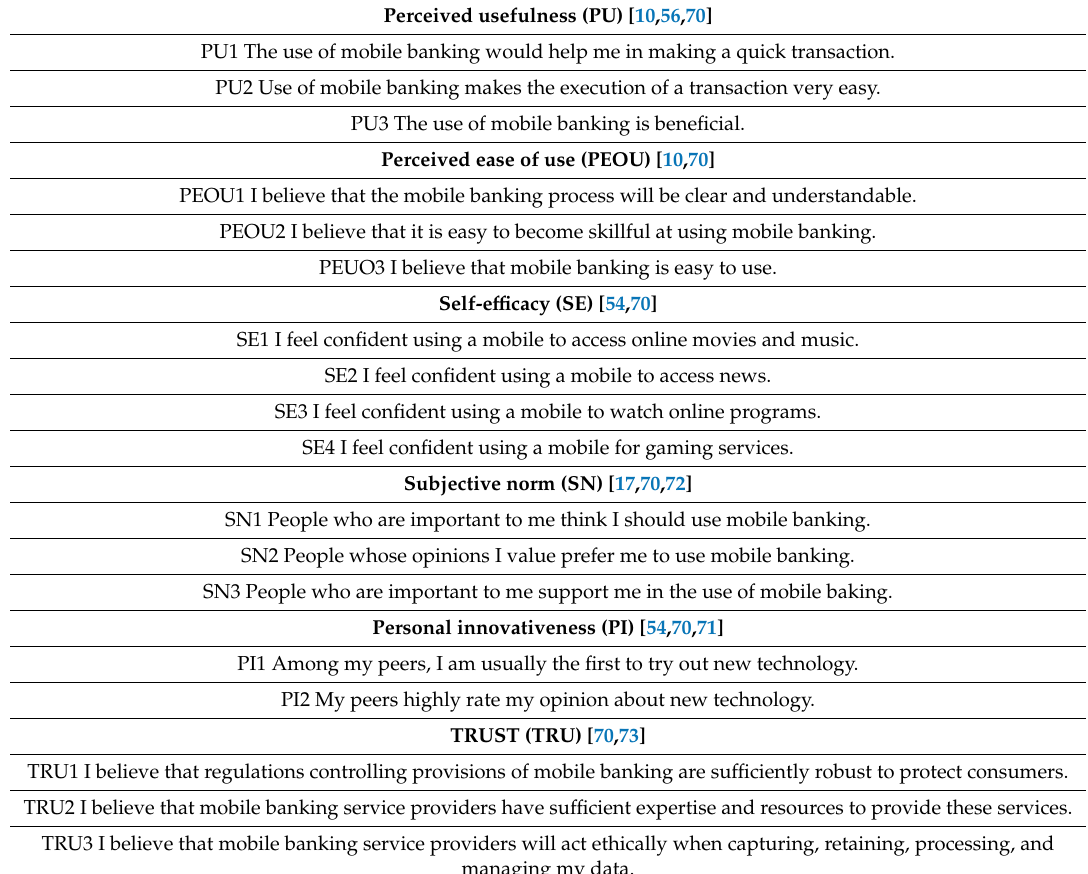
Table A1. Construct and Measurement